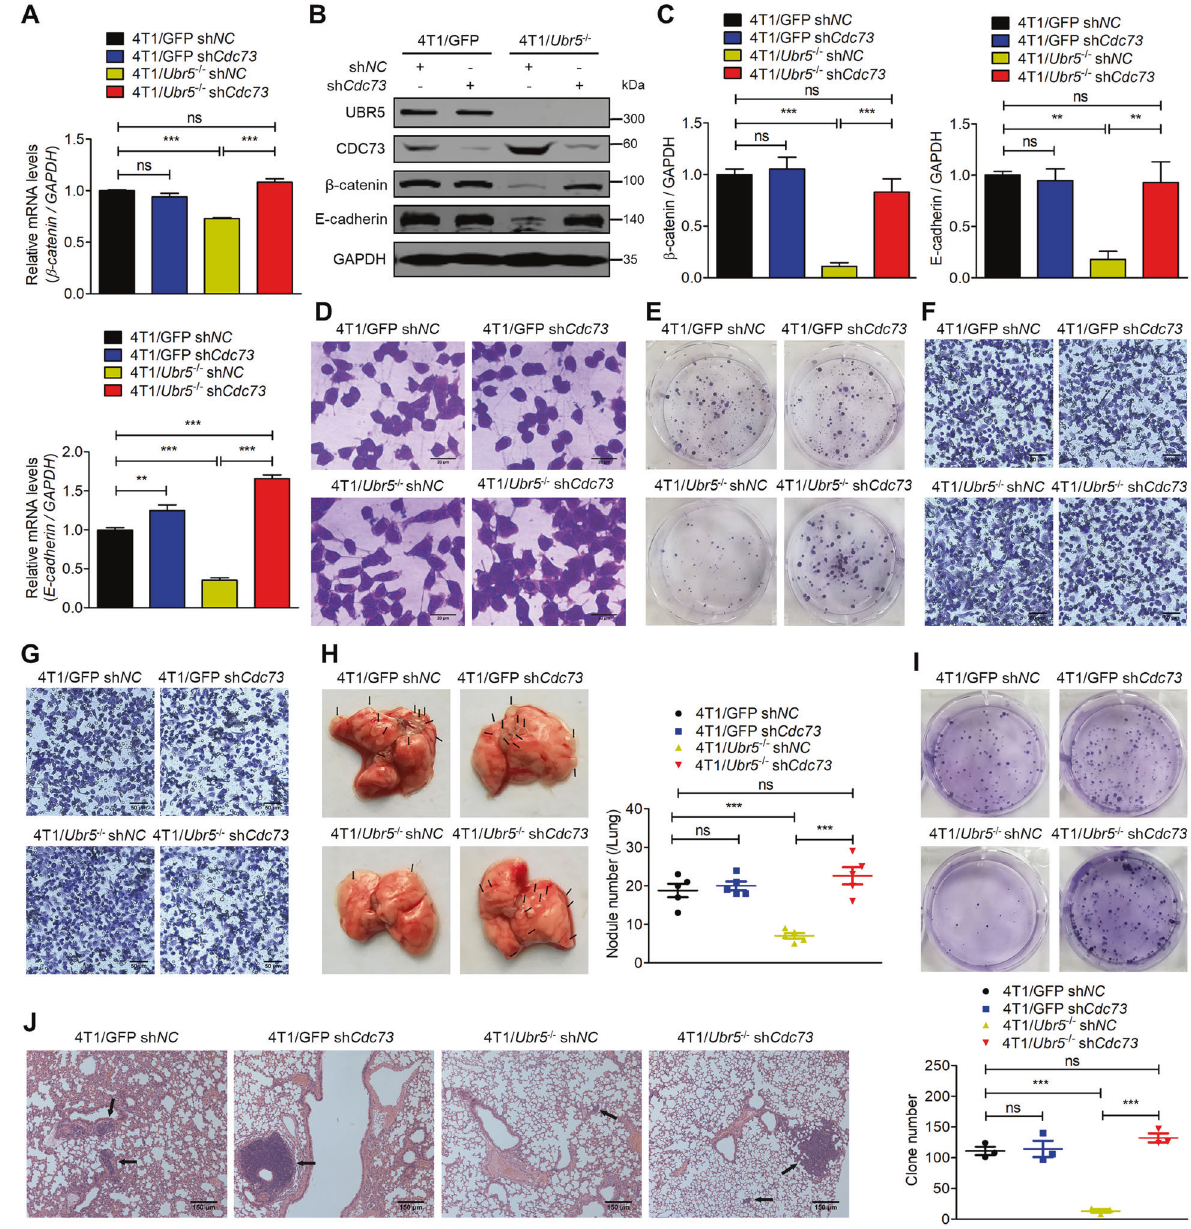
Fig. 4 CDC73 inhibits UBR5 ’ s metastatic activities. The mRNA expression ( A ), protein expression ( B ) and quanti fi cation ( C ) of β -catenin and E-cadherin were measured by qPCR and western blotting, respectively, in 4T1/GFP sh NC , 4T1/GFP sh Cdc73 , 4T1/ Ubr5 − / − sh NC , and 4T1/ Ubr5 − / − sh Cdc73 cells. D Representative images of the cell morphology analyzed for 4T1/GFP sh NC , 4T1/GFP sh Cdc73 , 4T1/ Ubr5 − / − sh NC , and 4T1/ Ubr5 − / − sh Cdc73 cells stained with 0.5% crystal violet. E Representative images of colonies of 4T1/GFP sh NC , 4T1/GFP sh Cdc73 , 4T1/ Ubr5 − / − sh NC , and 4T1/ Ubr5 − / − sh Cdc73 cells in colony formation assay in six-well plates (100 cells/well). Representative images of transwell migration ( F ) and invasion ( G ) were analyzed for 4T1/GFP sh NC , 4T1/GFP sh Cdc73 , 4T1/ Ubr5 − / − sh NC , and 4T1/ Ubr5 − / − sh Cdc73 cells, respectively. H Representative images of lungs in the tumor-bearing mice and the visible metastatic nodules on lung surfaces were counted. Female BALB/ c mice were intravenously injected with 2 × 10 5 4T1/GFP sh NC , 4T1/GFP sh Cdc73 , 4T1/ Ubr5 − / − sh NC , and 4T1/ Ubr5 − / − sh Cdc73 cells, respectively. The tumor-bearing mice were sacri fi ced and the lungs were harvested on day 21 ( n = 5). I Metastatic tumor cells of the lungs as described in ( H ) were visualized and quantitated by the 6-thioguanine clonogenicity assay ( n = 3). J Representative images of H&E staining of lung sections. Data were presented as mean ± SEM; ns not signi fi cant; ** p < 0.01; *** p <